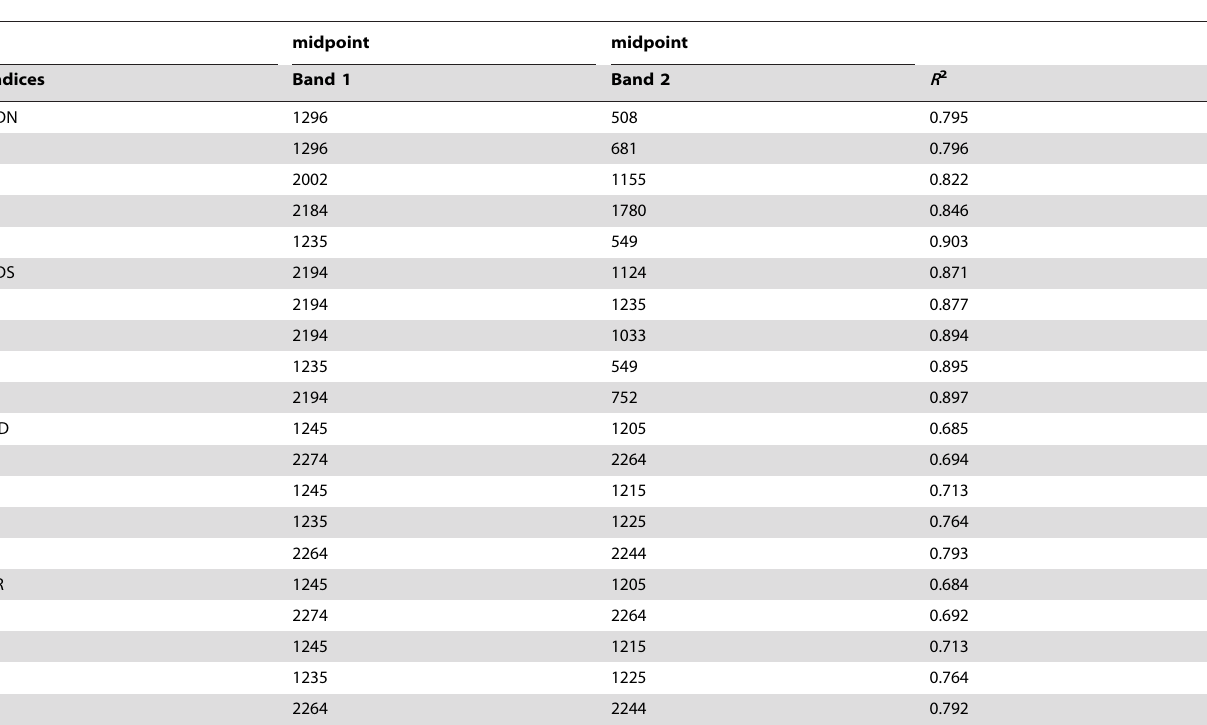
FDS=first derivative simple ratio index; ND=normalized difference index; SR=simple ratio index of; FDN=first derivative normalized difference